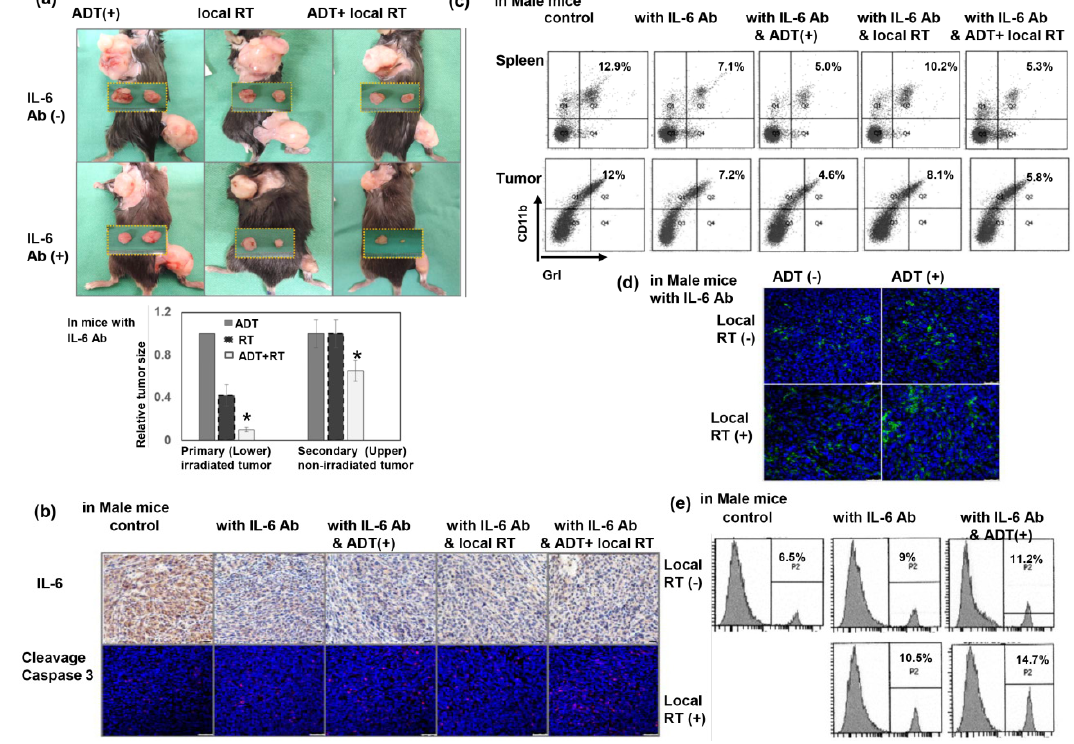
Figure 6. Inhibition of IL-6 enhanced the abscopal effect on metastatic CRPC. ( a ) The size of tumors (primary irradiated tumors and secondary non-irradiated tumors) was examined in CRPC-bearing mice with or without IL-6 blocking. Representative images and quantitative data are shown from the CRPC-bearing mice 7 days after three times 8 Gy to the right thigh tumor only (right thigh tumor: Primary irradiated tumor; upper beck tumor: Secondary non-irradiated tumor). The y axis represents the relative ratio, normalized to the tumor size of primary CRPC tumors in sham-irradiated mice treated with ADT and IL-6 antibodies (* p < 0.05). ( b ) Expression levels of IL-6 and cleavage caspase 3 of secondary non-irradiated tumors were evaluated by IHC (Scale bars: 20 µ m) and IF (Scale bars: 50 µ m) analysis, respectively. ( c ) Effect of IL-6 on the recruitment of MDSCs in the spleen and secondary non-irradiated tumors evaluated by FACS using GrI-CD11b staining in mice bearing CRPC tumors with or without IL-6 inhibition. The results are shown by representative slides. The effect of IL-6 on the number of TILs in secondary non-irradiated tumors was examined by immunofluorescence analysis using CD3 staining ( d ), and FACS using CD8 staining ( e ) in mice bearing CRPC with or without IL-6 inhibition. The results are shown by representative slides. Scale bars: 50 μ m.